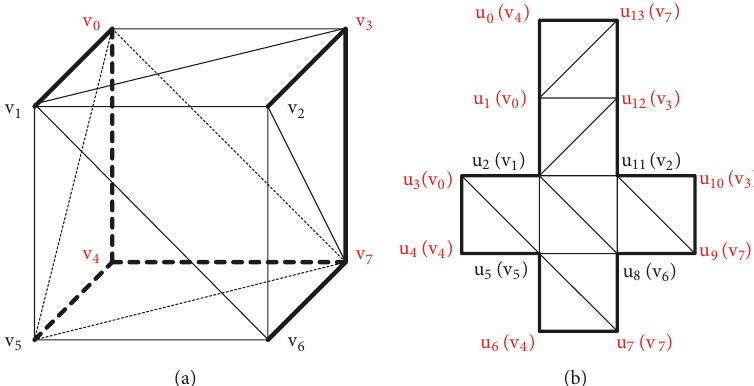
Figure 3: An example showing the process of unfolding a cube mesh and mapping it into a flatten patch in 2D texture space. (a) is the 3D cube mesh formed by 8 vertices and 6 triangles. (b) is the unfolded texture map formed by 14 pairs of texture coordinates and 6 triangles. Bold lines are the boundary edges (seams) to cut the cube, and the vertices in red are boundary vertices that are mapped into multiple pairs of texture coordinates. In (b), 𝑢 𝑖 stands for a point (𝑠 𝑖 ,𝑡 𝑖 ) in 2D texture space, and V 𝑖 in the parenthesis is the corresponding vertex in the cube.